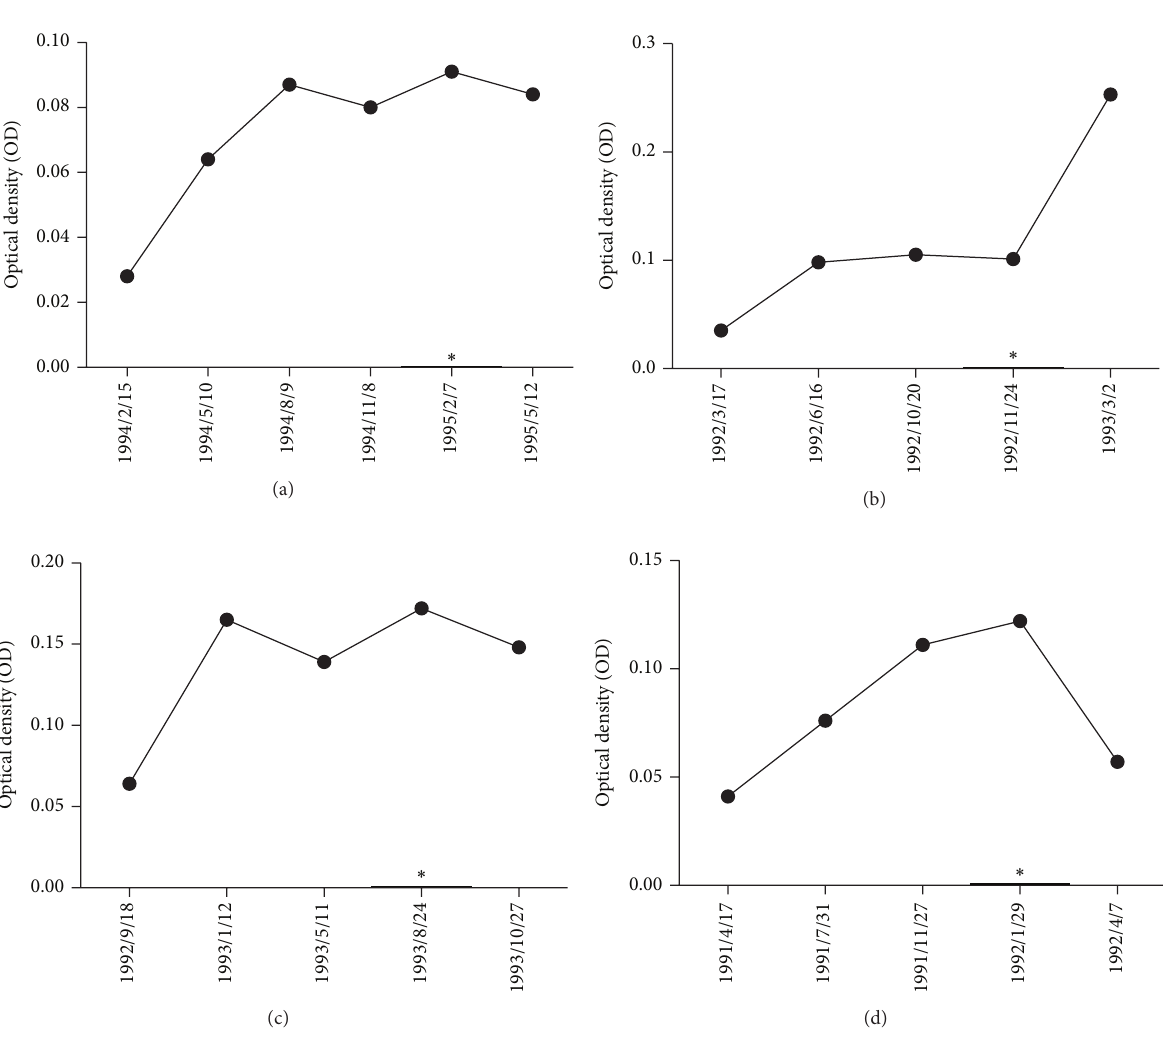
Figure 3: Autoantibody to MDM2 in serial serum samples from four HCC patients (cases 1, 2, 3, and 4). (a) First HCC patient (case 1) was diagnosed on 02/07/1995 with high titer of anti-MDM2 autoantibody. Totally, we had six serum samples within more than one year of time span collected from this HCC patient. The titer of anti-MDM2 autoantibody became higher at month 9 before HCC was detected. (b) Total of five serum samples were acquired from the second HCC patient (case 2). The titer of anti-MDM2 autoantibody became high at month 6 before the date (11/24/1992) of HCC diagnosed. There was low titer of anti-MDM2 autoantibody before 03/17/1992. (c) The third HCC patient (case 3) was diagnosed at the date of 08/24/1993, with a high titer of anti-MDM2 autoantibody. During one-year period (09/18/1992 to 10/27/1993), six serum samples collected from this patient showed that the titer of anti-MDM2 autoantibody became higher at month 6 before HCC was detected. (d) The fourth HCC patient (case 4) was diagnosed at the date of 01/29/1992, and five serum samples were acquired for test. From 04/17/1991 to 01/29/1992 (the date of detection), a gradually increased titer of anti-MDM2 autoantibody can be seen. It became high at month 6 before HCC was detected. The asterisk means the date of HCC